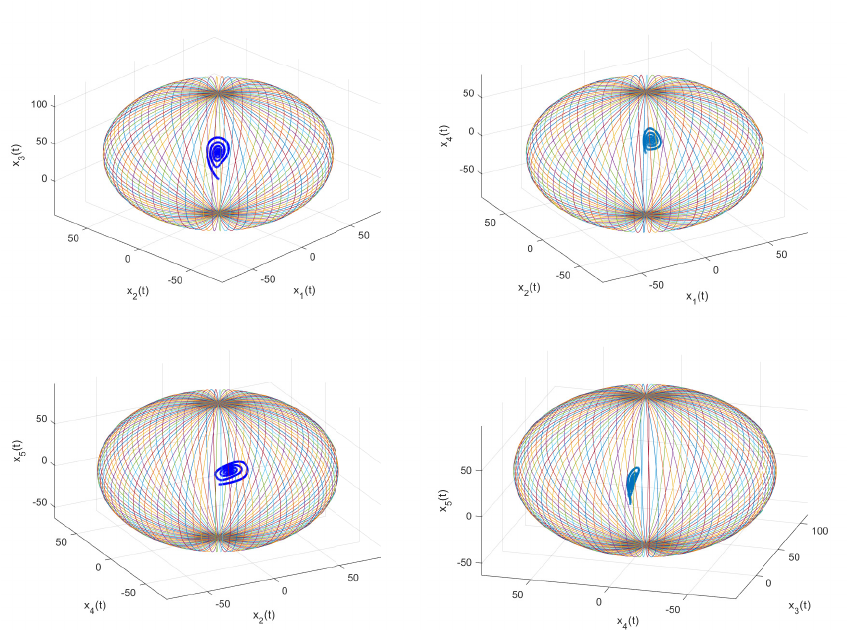
) of system (13), where σ = 10, b = 8 U 1,1